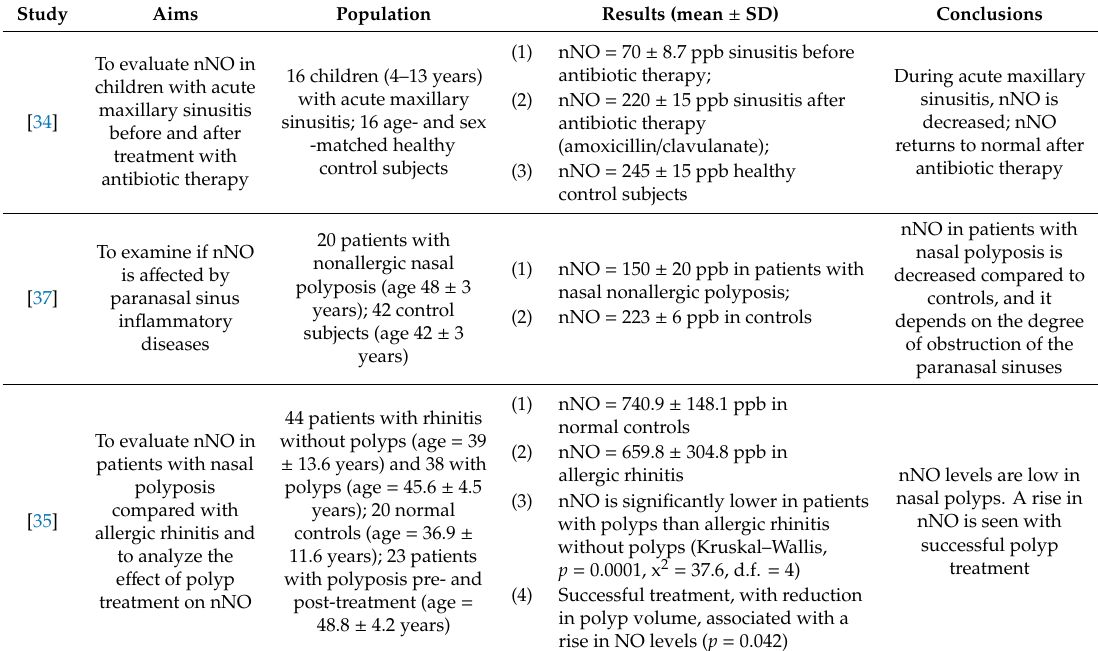
Table 1. List of studies that evaluated nasal nitric oxide (nNO) in